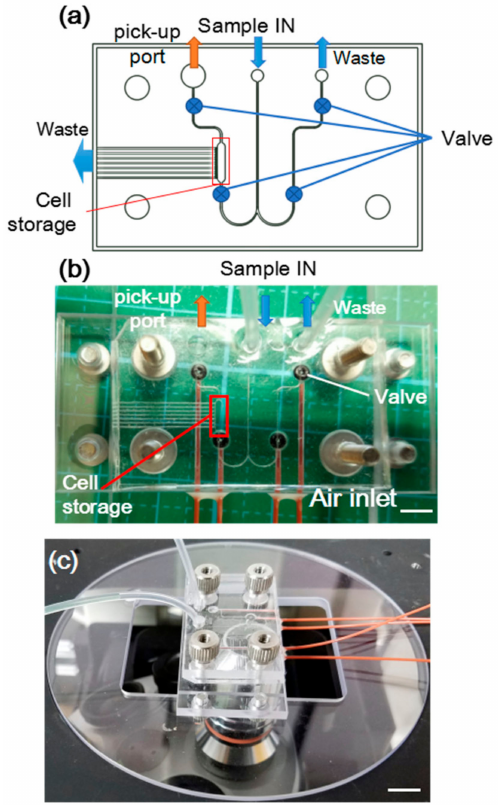
Figure 5. Prototype of cell capturing device equipped with PDMS membrane actuator. ( a ) Design of the device. ( b ) Prototype device with 4 air inlets, 1 sample inlet, 2 waste-outlets and a pick-up port. The scale bar is 5 mm. ( c ) The fully assembled cell capturing device equipped with PDMS membrane actuator was mounted on a microscope. The scale bar is 10 mm.